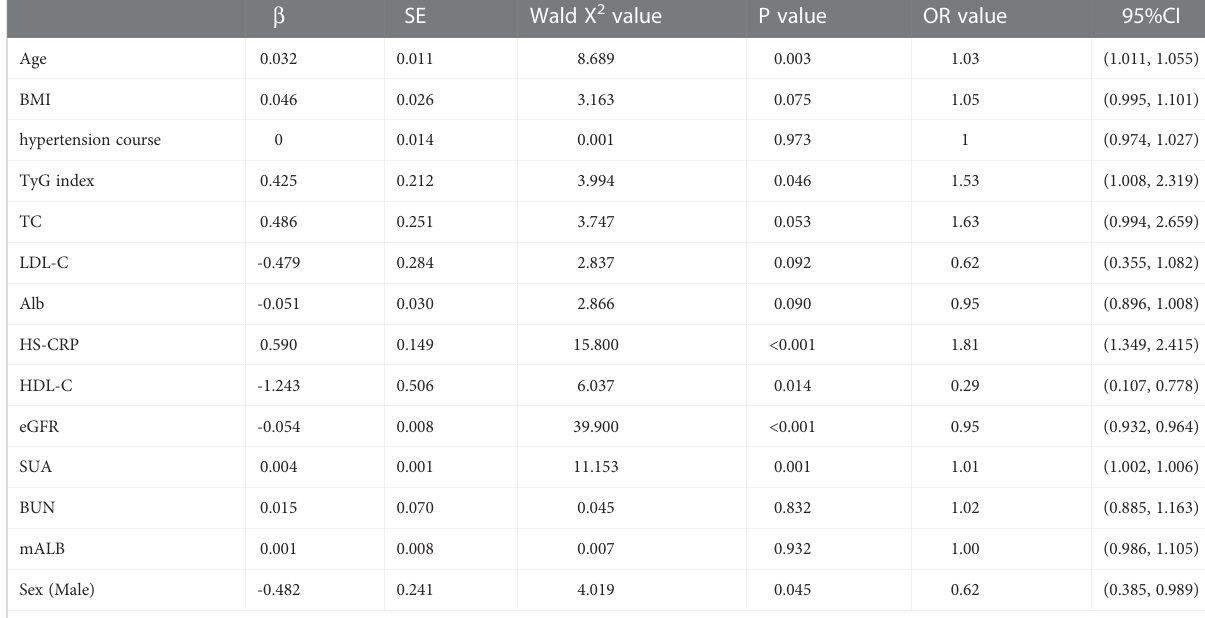
Abbreviations as given in Table